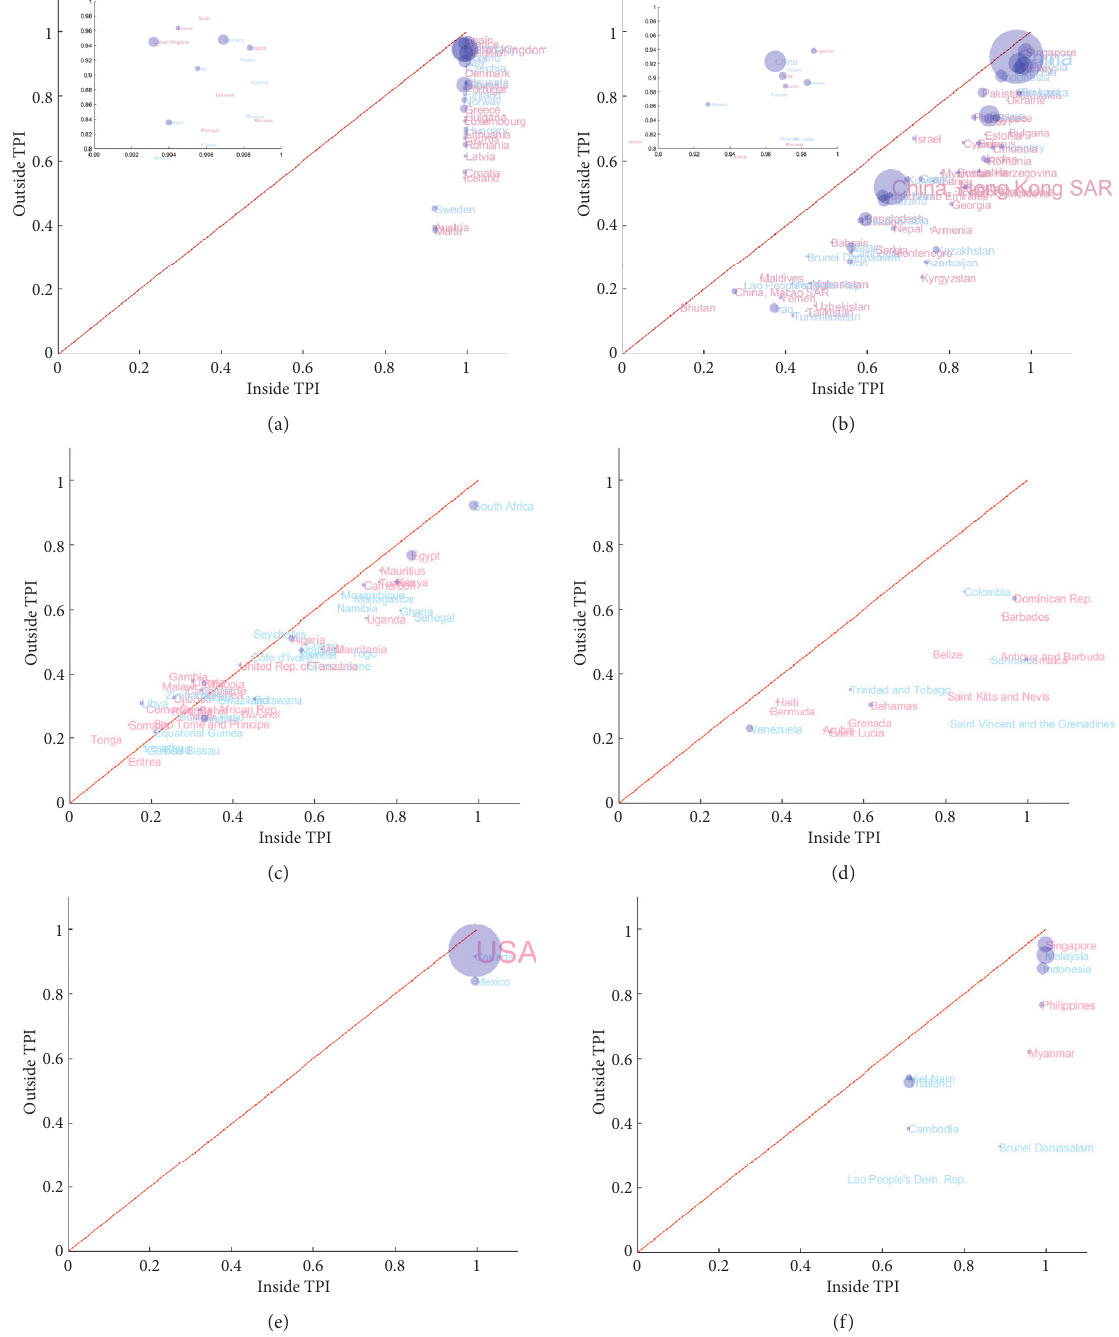
Figure 7: Trade resistance in six different trade unions for the year 2017: (a) European Union (EU) countries; (b) Belt and Road (BRI) countries; (c) Organization of African Union (OAU) countries; (d) Caribbean Free Trade Area (CARIFTA) countries; (e) North American Free Trade Agreement (NAFTA) countries; (f) Association of Southeast Asian Nations (ASEAN)